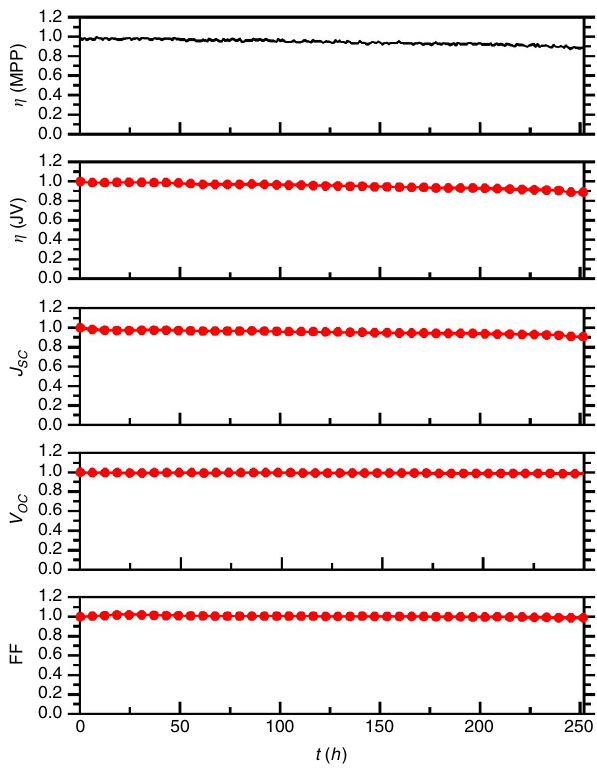
Figure 7 | Evolution of normalized photovoltaic parameters. The photovoltaics parameters were measured over 250h under continuous 1 sun illumination, MPP tracking and 25 (cid:2) C. Z ( MPP; top, black line). Z (J–V) and other parameters (red line and circles). MPP was tracked hourly, and J – V s were scanned every 6h. The initial solar cell value is: V OC : 910mV, J SC : 15.1mAcm (cid:2) 2 , FF (%): 70.5, Z (%):